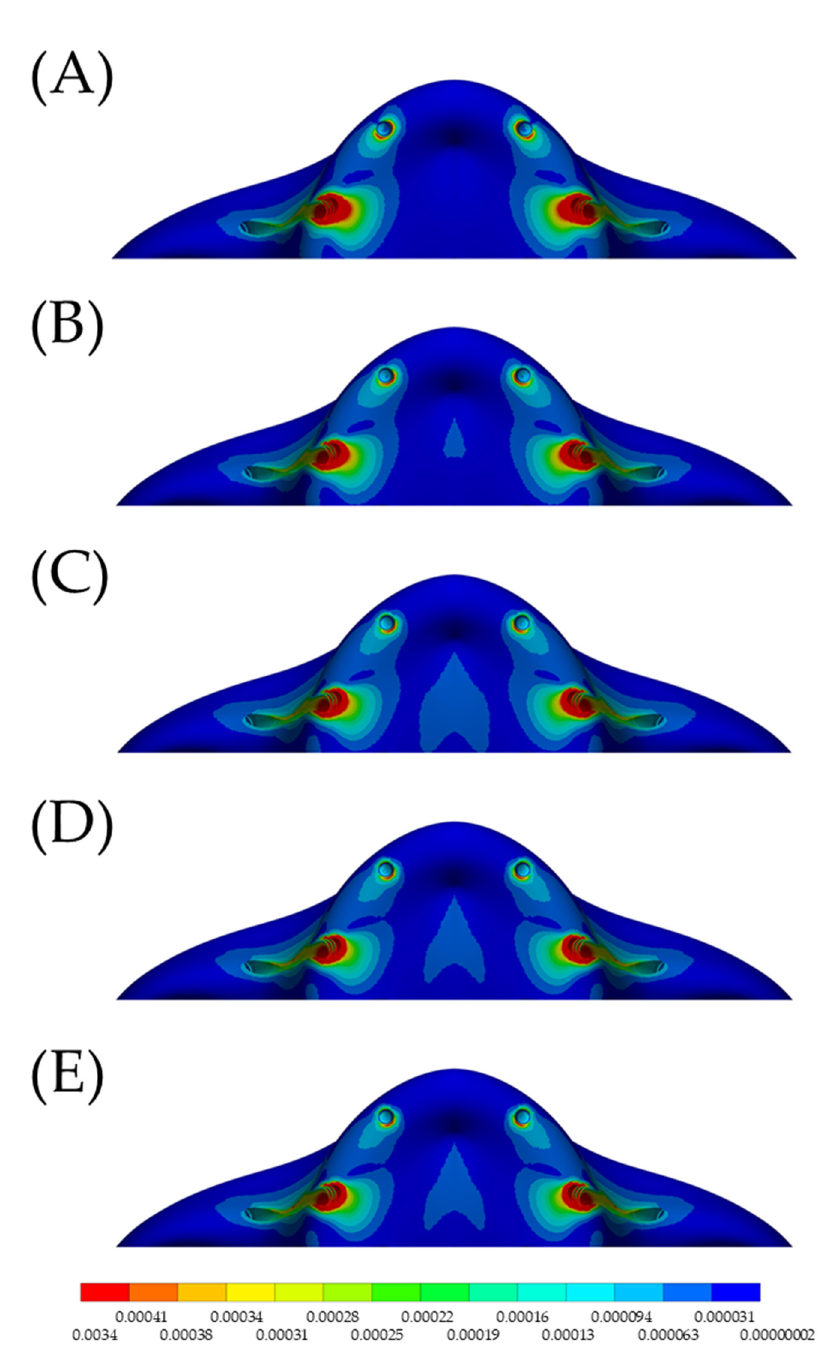
Figure 5. Occlusal view of the microstrain distribution in the maxillary bone according to the different superstructure materials. ( A ) PEEK, ( B ) CF, ( C ) Ti, ( D) CoCr and ( E ) Zi. There is higher stress in the posterior implant regardless of the evaluated